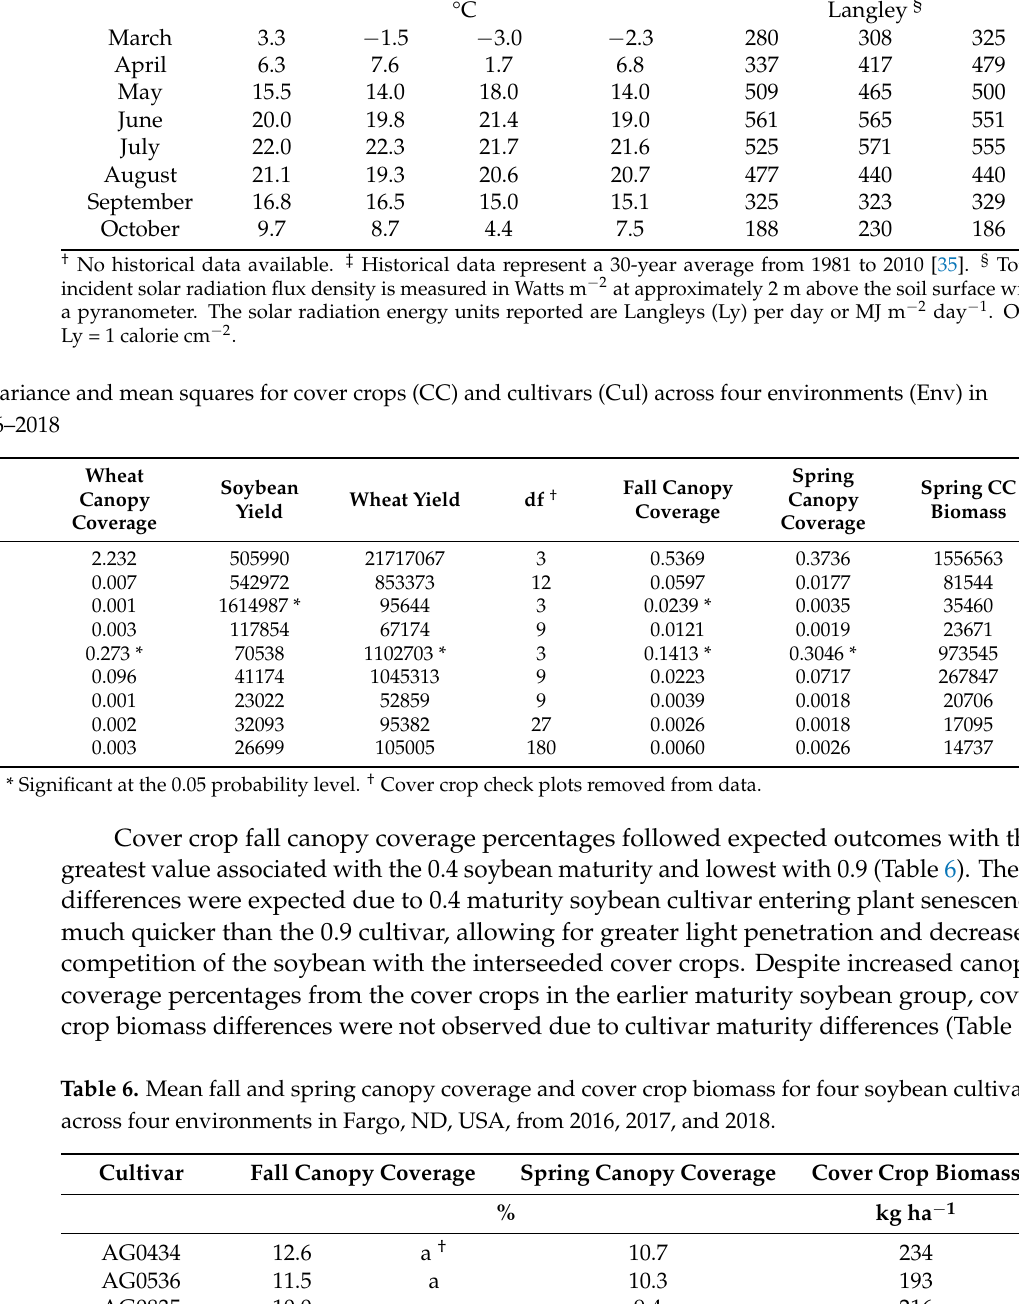
Table 4. Monthly average air temperature and solar radiation for 2016, 2017, and 2018, and historical data for average air temperature at Fargo, ND, USA.